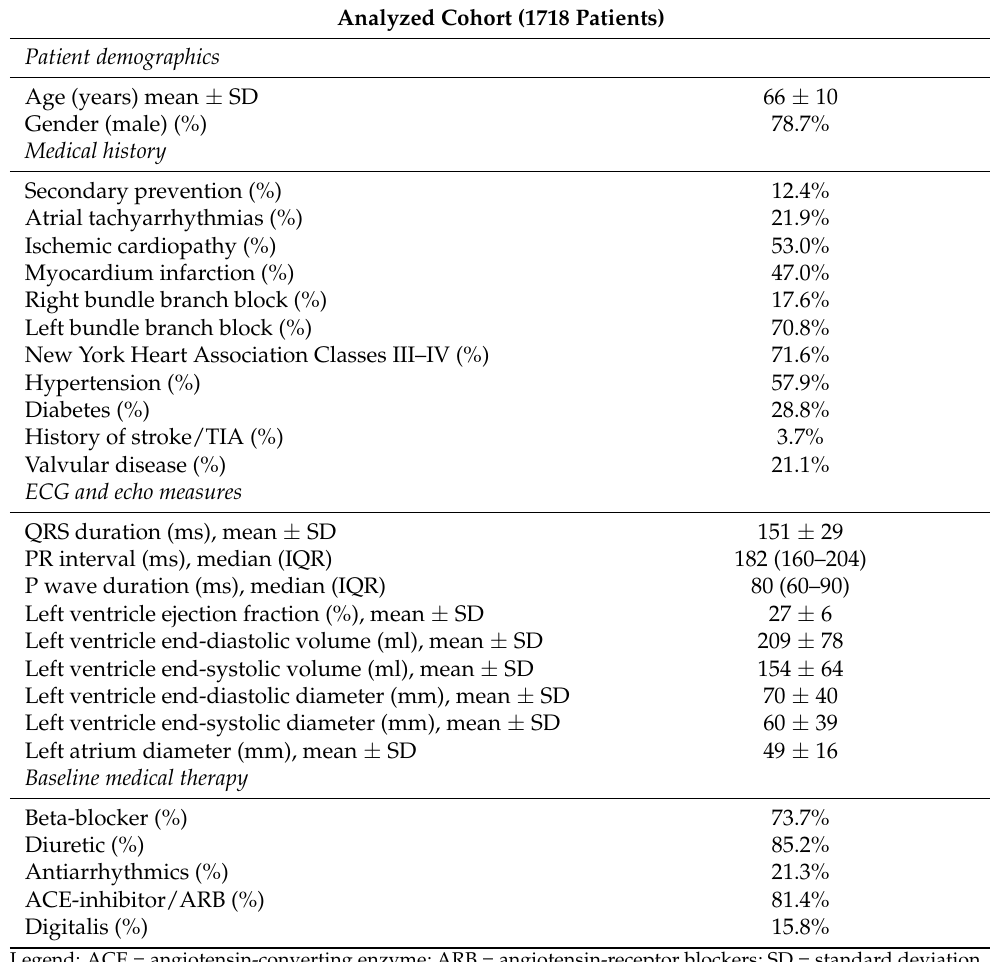
Table 1. Patient demographics and baseline